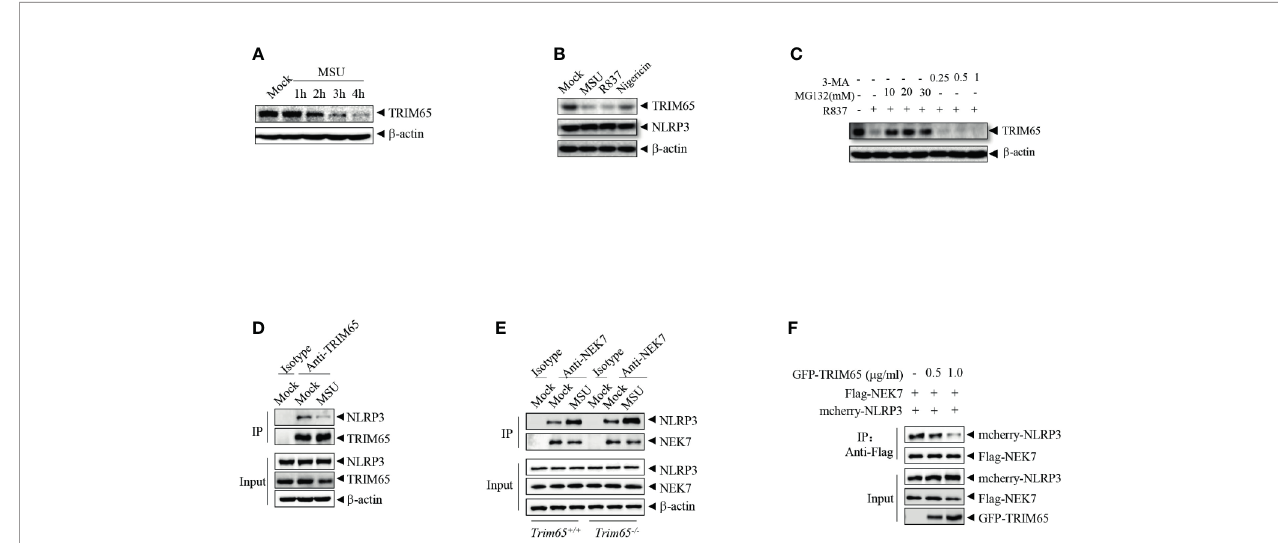
FIGURE 4 | NLRP3 agonists promote TRIM65 reduction to favor NEK7-NLRP3 interaction and NLRP3 in fl ammasome assembly. (A) PMA-differentiated and LPS- primed THP-1 cells were stimulated with MSU for different durations, and the expression of TRIM65 was analyzed by western blotting. (B) PMA-differentiated and LPS-primed THP-1 cells were stimulated with MSU, R837 or nigericin, and the expression of TRIM65 was analyzed by western blotting. (C) PMA-differentiated and LPS-primed THP-1 cells were treated with different doses of proteasome inhibitors (MG132, 1 h) or autophagy inhibitors (3-MA, 3 h), and then stimulated with R837 for 4 h, and the expression of TRIM65 was analyzed by western blotting. (D) PMA-differentiated and LPS-primed THP-1 cells were stimulated with MSU, and the endogenous interaction between NLRP3 and TRIM65 was analyzed by immunoprecipitation and western blotting. (E) LPS-primed BMDM cells were stimulated with ATP and Nigericin, and the interaction between NLRP3 and NEK7 was analyzed by immunoprecipitation and western blotting. (F) Mcherry-NLRP3 and Flag-NEK7 were cotransfected with or without GFP- TRIM65 in HEK-293T cells. The interaction between NLRP3 and NEK7 was analyzed by immunoprecipitation and western blotting. Data are representative of three independent